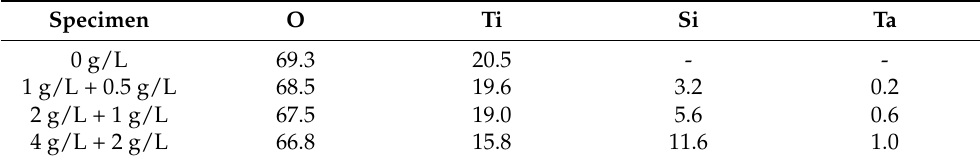
Table 3. Percentage of elements in the MAO coatings with different concentration of Si 3 N 4 /TaC particles (at. %).